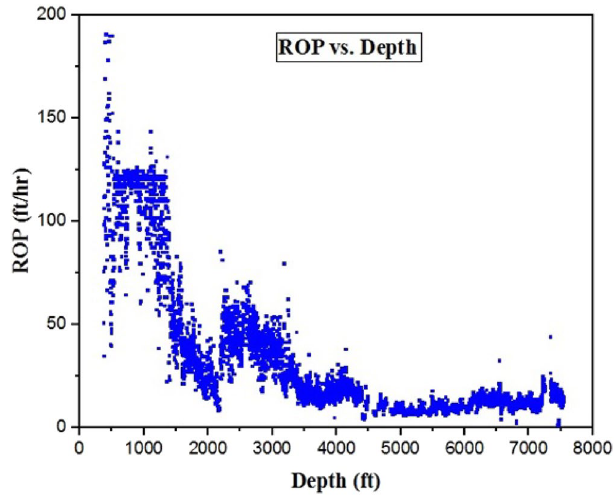
Figure 8. The relation between ROP and